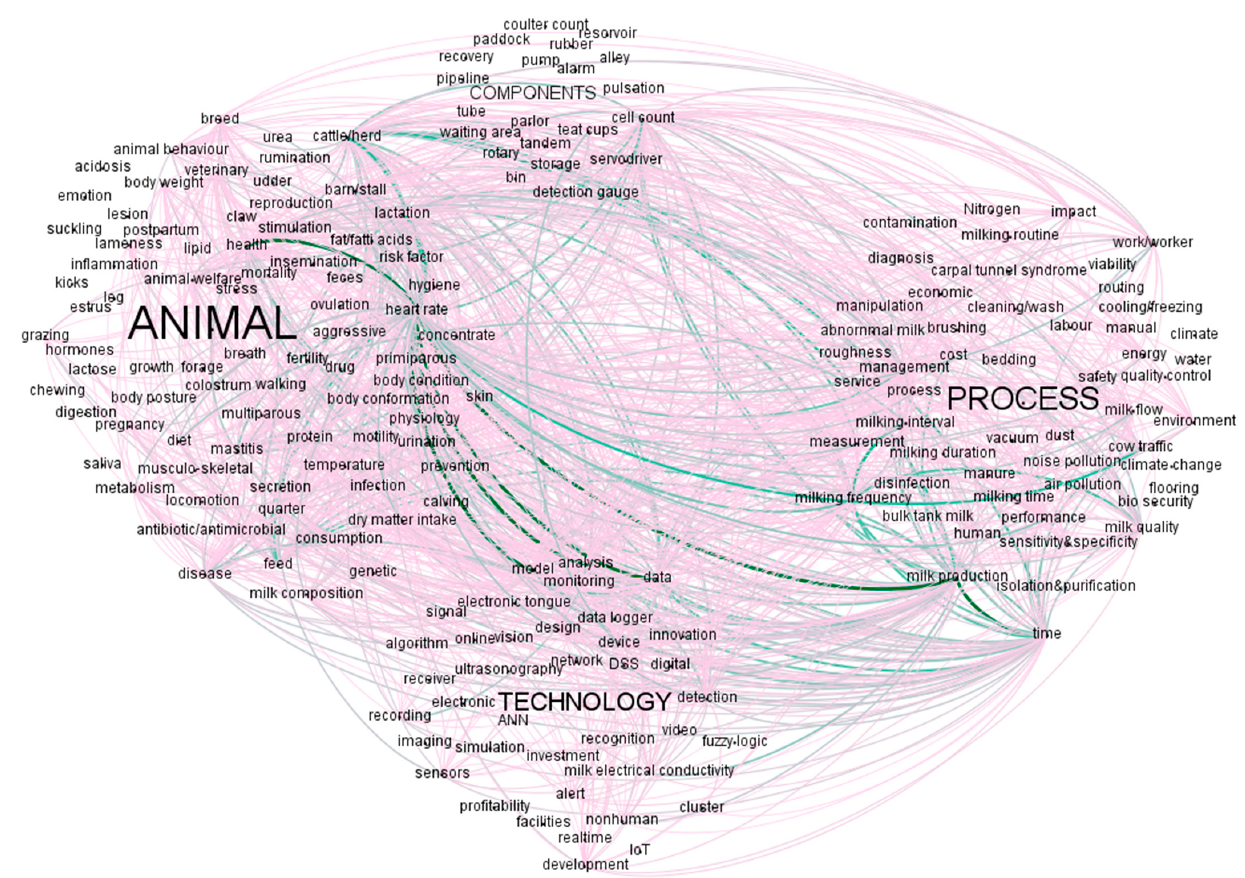
Figure 6. Papers: overview of the words grouped into clusters. The size of the label of the cluster name is proportional to the cluster weight. Co ‐ occurrence of topics is represented by edges, which thickness and darker color of the lines indicate a larger number of connections. Co ‐ occurences lower than 4 were not represented.